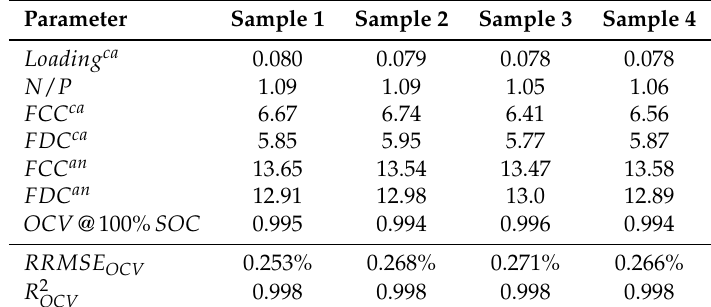
Table 3. Optimal dimensionless values for the decision variables in the open circuit voltage (OCV) calibration.